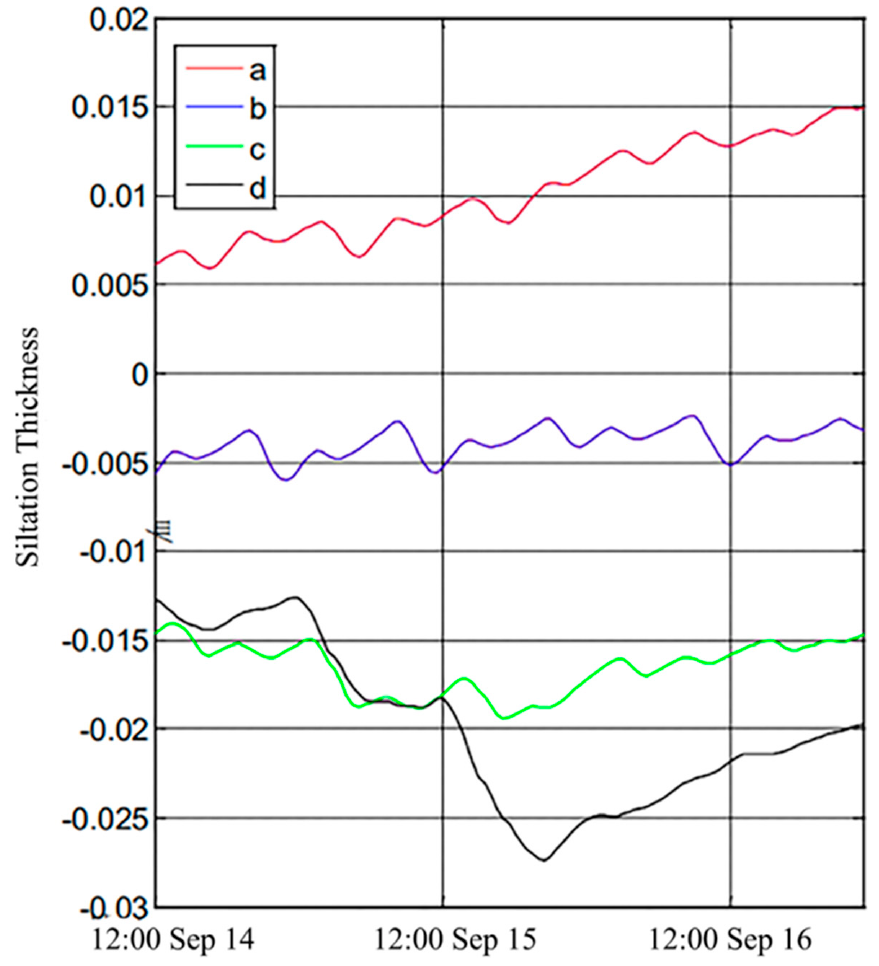
Figure 12. Scouring process at pipelines for different points.